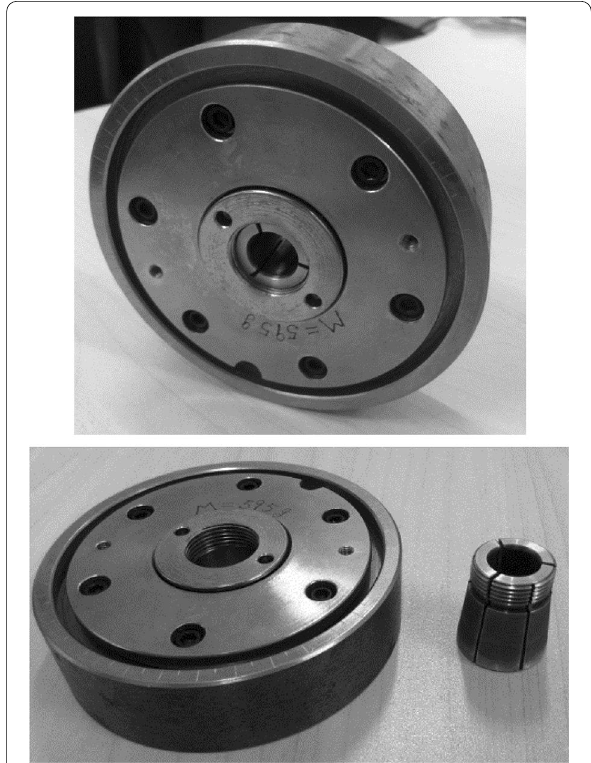
Figure 15 Structure of the loose